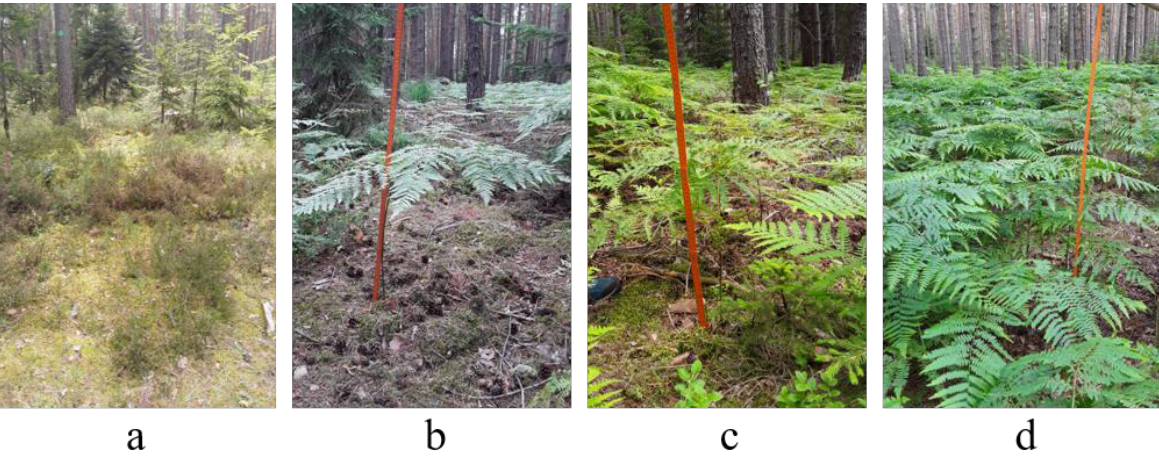
Figure 3: Determined fern density classes: a) overview of forest floor and class 0 (no fern), 14.06.2020; b) class 1 (approx. 33% fern cover), 17.06.2020; c) class 2 (approx. 66% fern cover), 17.06.2020; d) class 3 (full fern cover), 17.06.2020.